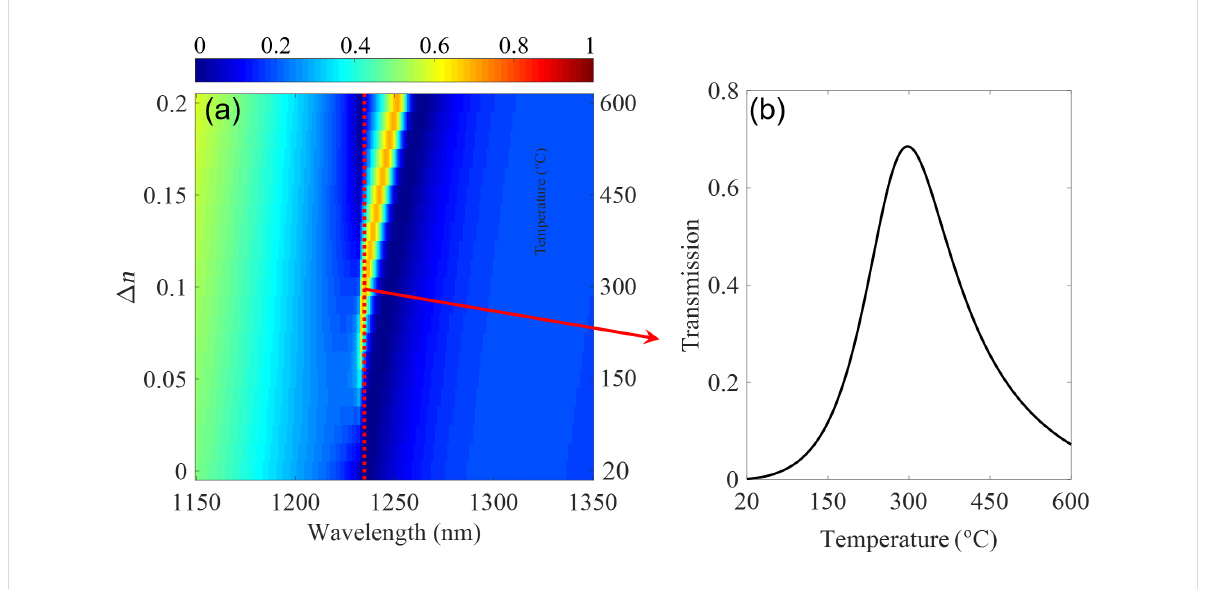
Figure 4: (a) The transmission spectrum during the heating process. (b) The transmission at 1235 nm during the heating process.